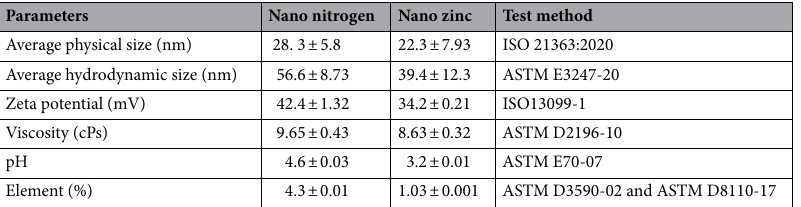
Table 1. Characterization of nanofertilizers: nano nitrogen and nano zinc.